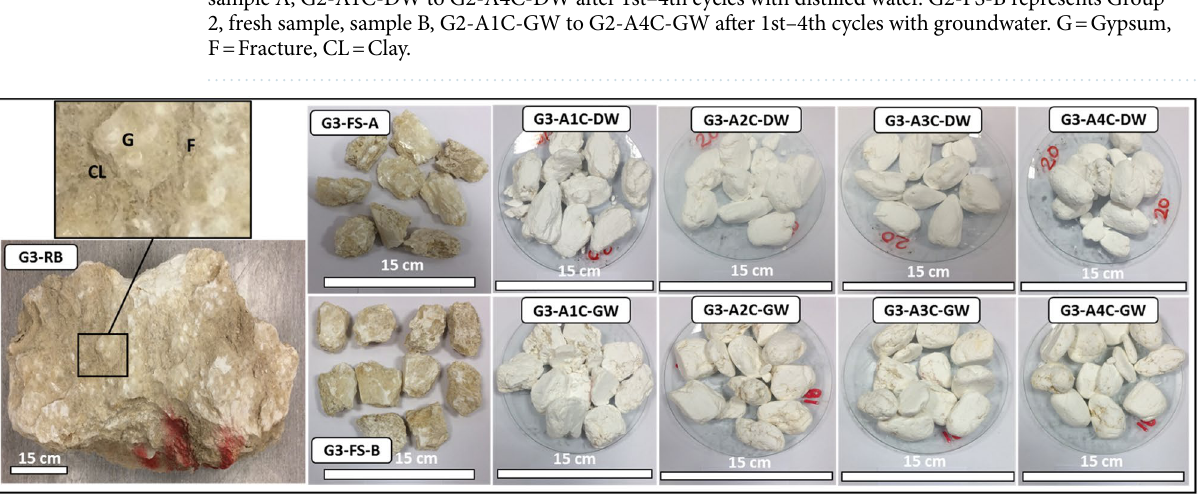
Figure 5. Representative evaporitic rock block (G3–RB; Group 3, Rock Block) and slake durability test samples cycled with distilled water and groundwater (1st–4th cycles). G3-FS-A represents Group 3, fresh sample, sample A, G3-A1C-DW to G3-A4C-DW after 1st–4th cycles with distilled water. G3-FS-B represents Group 3, fresh sample, sample B, G3-A1C-GW to G3-A4C-GW after 1st–4th cycles with groundwater. G = Gypsum, F = Fracture, CL =